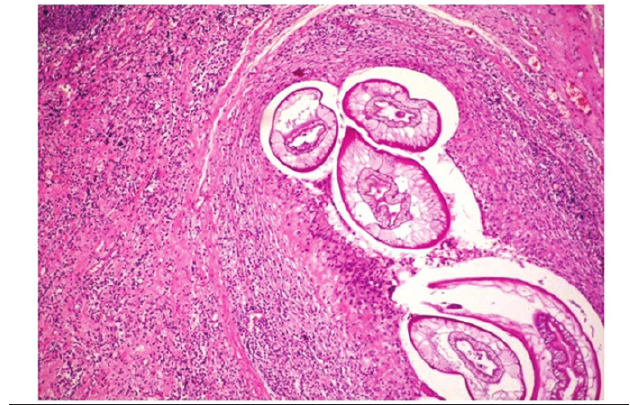
figurE 4 − Granulomatous reaction around adult worms (HE, 100×) HE: hematoxylin and